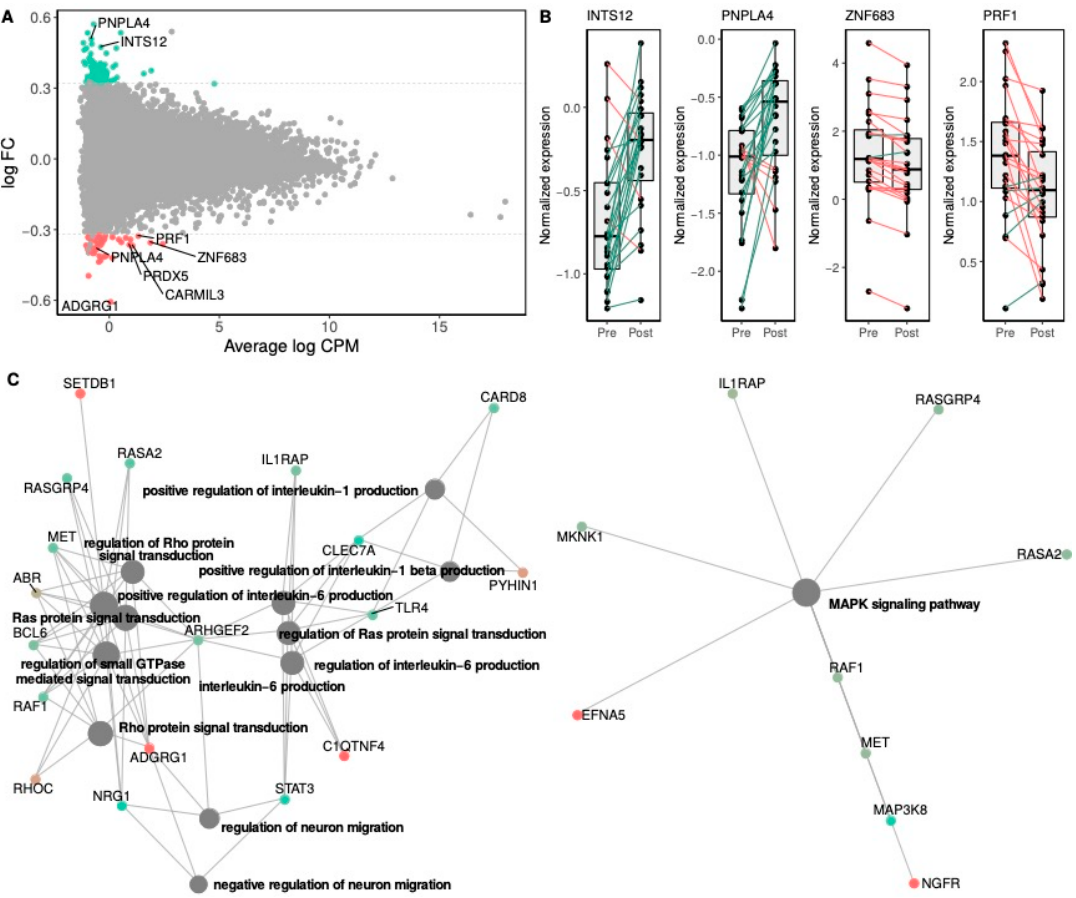
Figure 3. Gene expression change between pre- and post-supplementation states in the Rb group. Panel ( A ) shows the log2 average abundance of transcripts in counts per million mapped reads (log CPM) on the x-axis and the log2 fold-change (log FC) on the y-axis. Non-significant genes are represented by grey dots. Over- and under-expressed genes (FC > 1.25) with unadjusted significant di ff erences (paired t-test p -value < 0.05) are colored in green and red, respectively. Significant di ff erentially expressed genes from paired t-tests ( p -value < 0.001) and showing at least a 1.25 FC are labeled with gene names. The dashed lines represent 1.25 FC. Panel ( B ) shows the top di ff erentially expressed genes between pre- and post-supplementation states in the Rb group. Box and whisker plots show median, first, and third quartiles, and maximum and minimum values for the 24 sample pairs before (Pre) and after (Post) the Rb supplementation. The three transcripts, which exhibited the most significant ( p -value < 0.001) over- and under-expression derived from paired t -tests (post vs. pre), are shown on the top and bottom rows, respectively. Green and red lines stand for increasing or decreasing gene expression levels between pre- and post-supplementation states within individual paired samples. Panel ( C ) shows network plots of enriched terms following the Rb supplementation. Network plots depict the linkages among di ff erentially regulated gene clusters and functional enriched terms in the Gene Ontology Biological Processes (GO-BP) (left) and Kyoto Encyclopedia of Genes and Genomes (KEGG) (right) pathway databases. The size of the grey dots is proportional to the number of genes in the enriched pathway (from 7 to 13 genes), and the red-to-green color gradient of gene dots represents the direction of the gene expression fold-change following the Rb